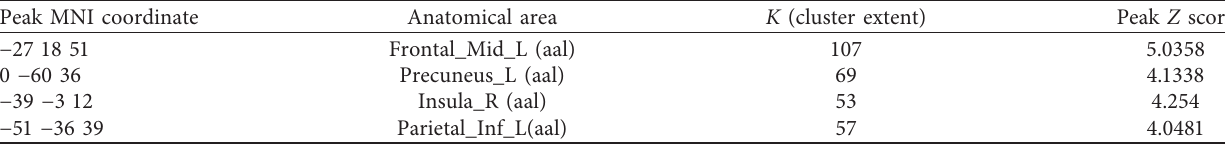
Table 1: Regions of P300 FMRI activation to the novels.